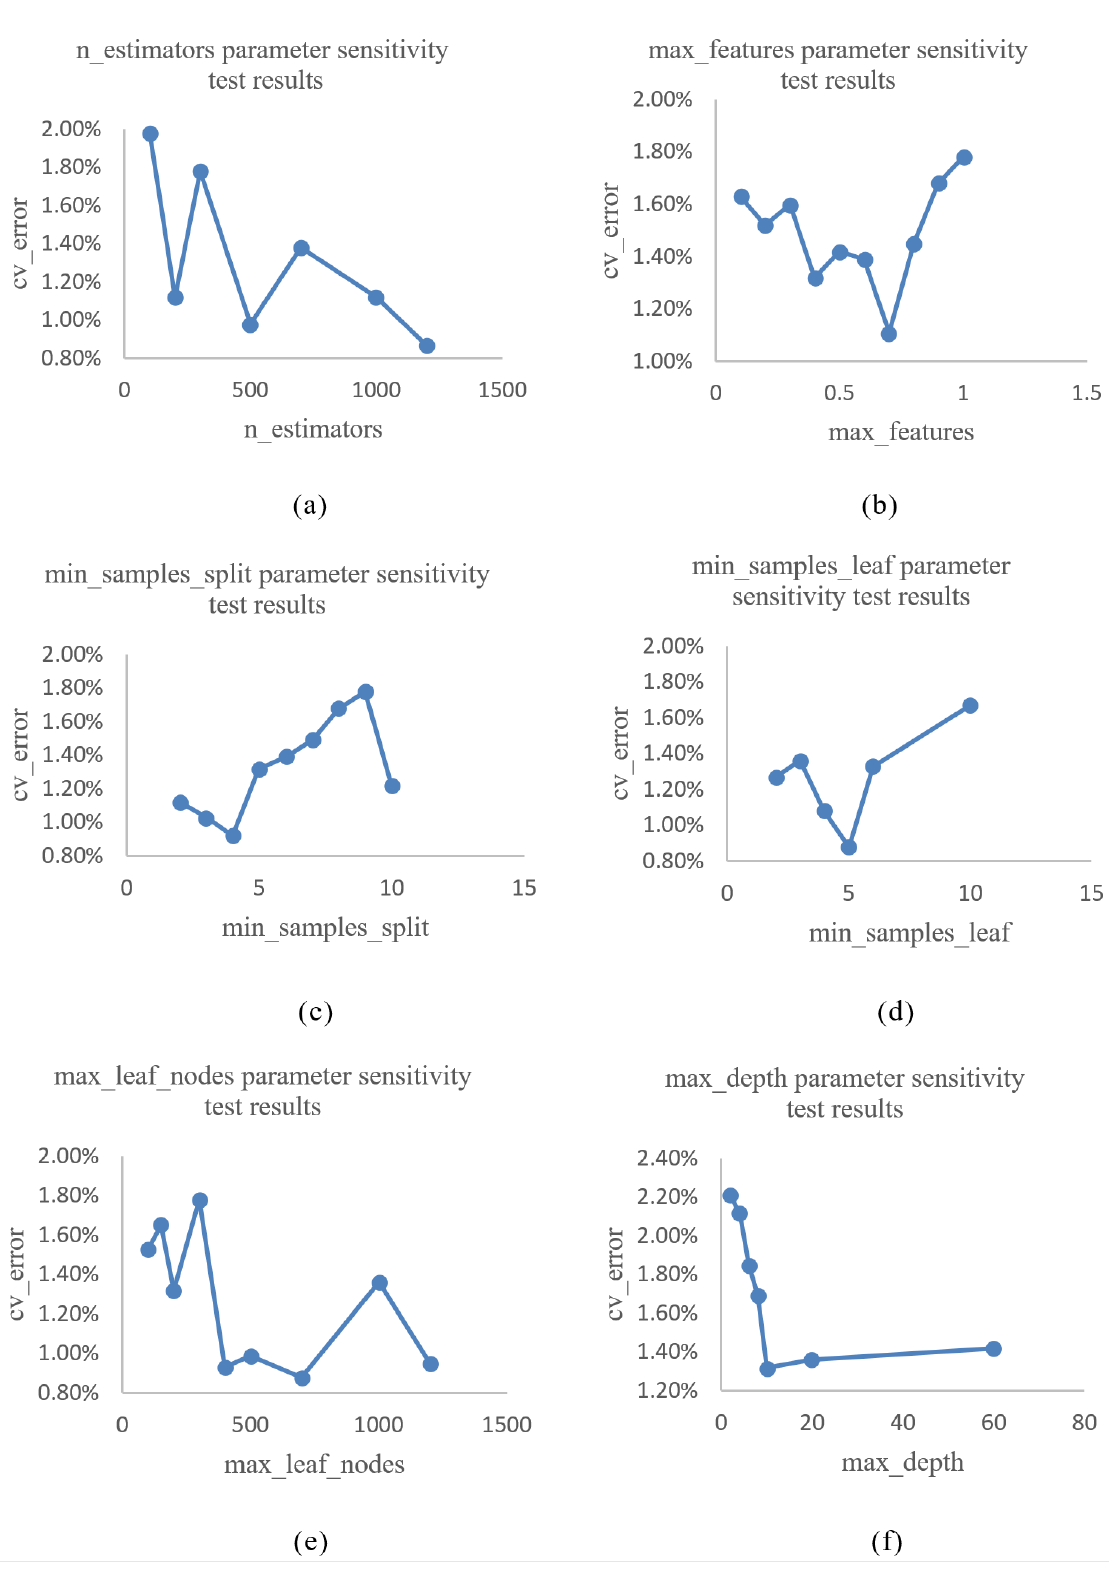
Figure 5. Random forest parameter sensitivity test results. ( a ) n_estimators parameter sensitivity test results. ( b ) max_features parameter sensitivity test results. ( c ) min_samples_split parameter sensitivity test results. ( d ) min_samples_leaf parameter sensitivity test results. ( e ) max_leaf_nodes parameter sensitivity test. ( f ) max_depth parameter sensitivity